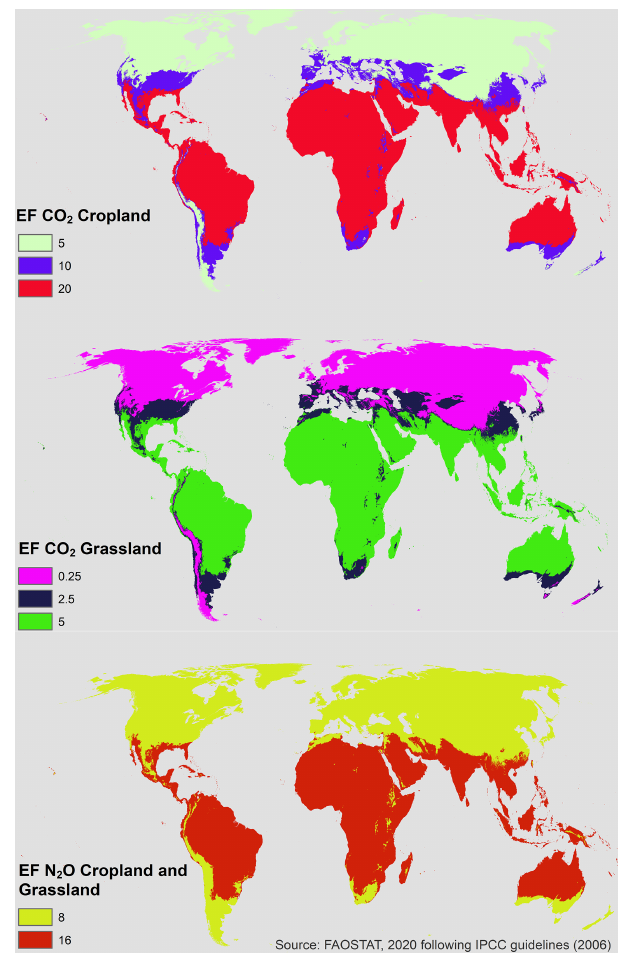
Figure 5. Spatial layers of emission factors from the IPCC (2006) by gas, land use and climatic zone.